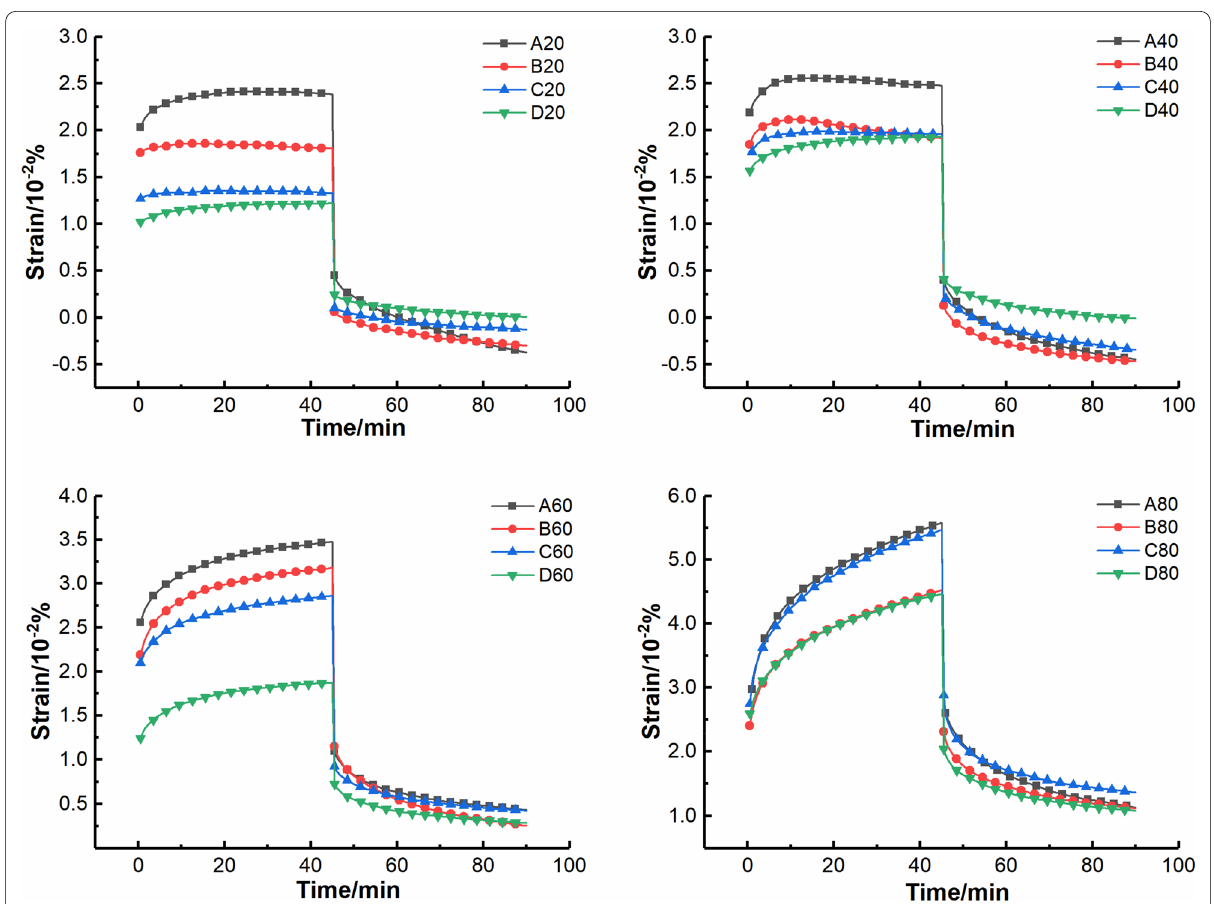
Fig. 7 Creep behaviors of the specimens with various distributions of earlywood vessel